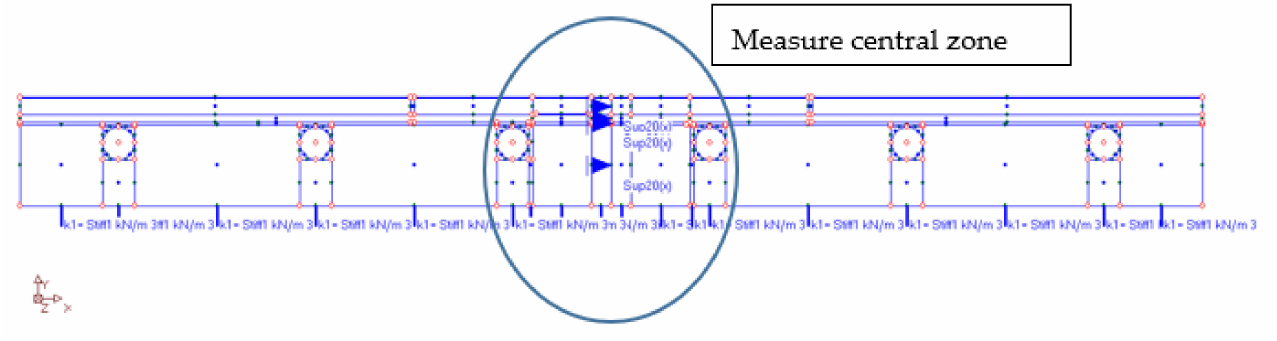
Figure 15. The computer model of the studied structure.